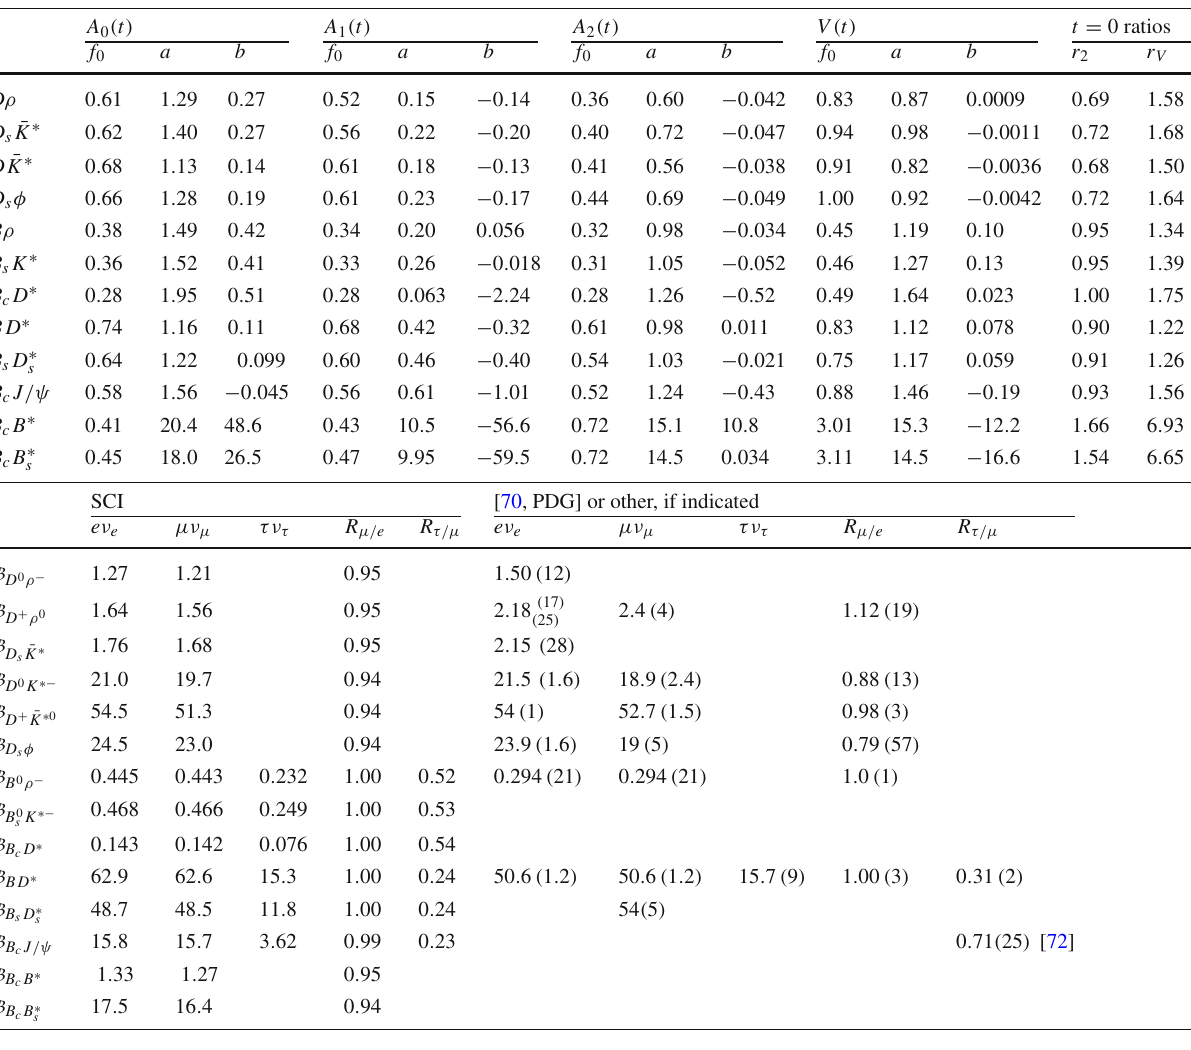
entries should be multiplied by 10 − 3 .) Ref. [70] lists | V cd | = 0 . 221 ( 4 ) ,